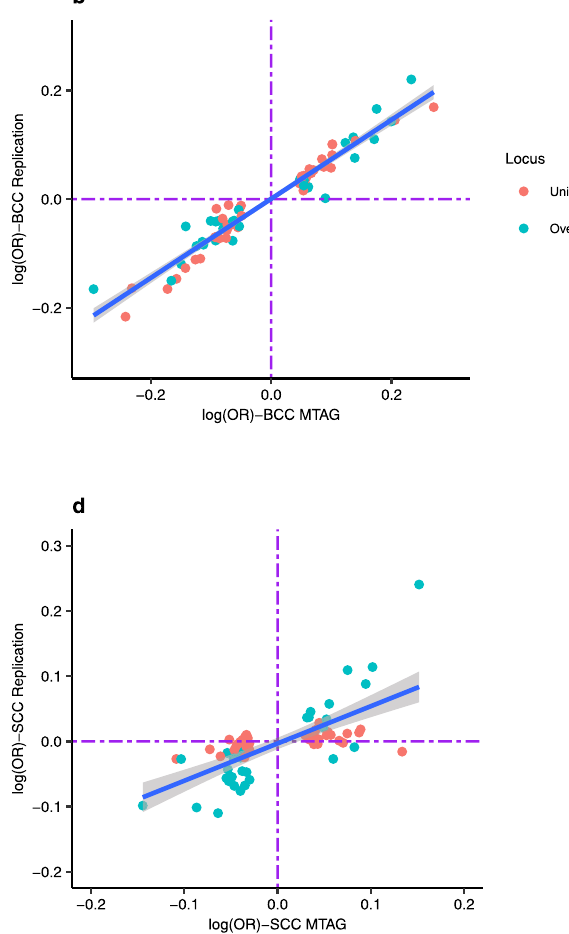
Fig.4|Concordanceofthelog(OR)effectestimatesforMTAGversusUKsingle- traitGWASand23andMereplication. Figure4showsthecomparisonoftheeffect estimatesinlog(oddsratio)forbothbasalcellcarcinoma(BCC)andsquamouscell carcinoma (SCC) based on the respective MTAG approach results versus UKB single-traitGWASand replication resultsfrom 23andMe. The blue line is the line of best fi twiththe 95%con fi denceintervals.The bluedots represent locithatoverlap between BCC and SCC, whilst the red dots show the loci that are respectively unique to BCC or SCC. The dotted purple lines represent null effects (i.e. log (OR)=0). The Y- and X- axes represent log (OR). a Shows BCC MTAG versus UKB